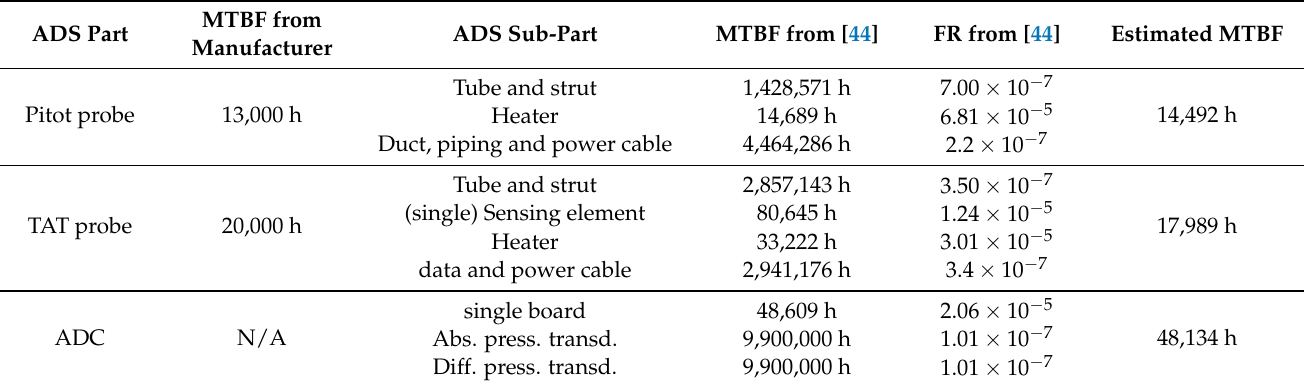
Table 4. ADS parts and related mean time between failure (MTBF) declared by the part manufacturer, whereas the sub-part MTBF is retrieved from [44] and the “Estimated MTBF” is calculated using Equation (9). ADS